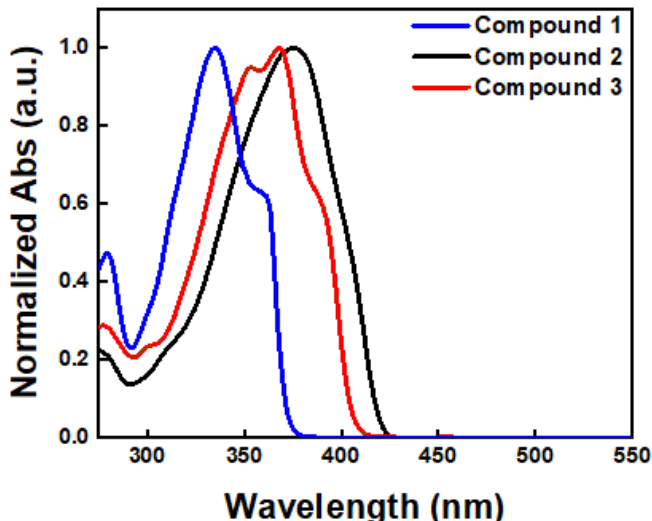
Figure 2. Optical absorption spectra of Compounds 1– 3 .